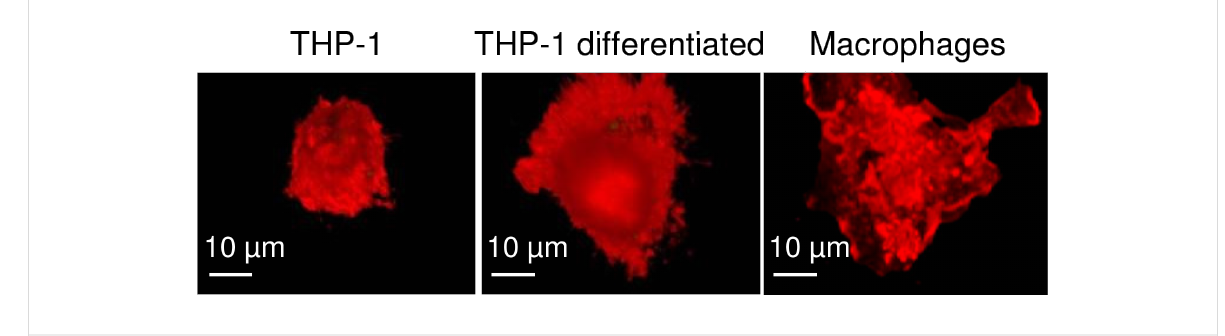
Figure 2: Spinning disc confocal microscopy of acute monocytic leukemia THP-1 cells, differentiated THP-1 cells, and human macrophages. Cell membranes are stained with CellMask (red). Adapted with permission from [43]. Copyright 2011 American Chemical